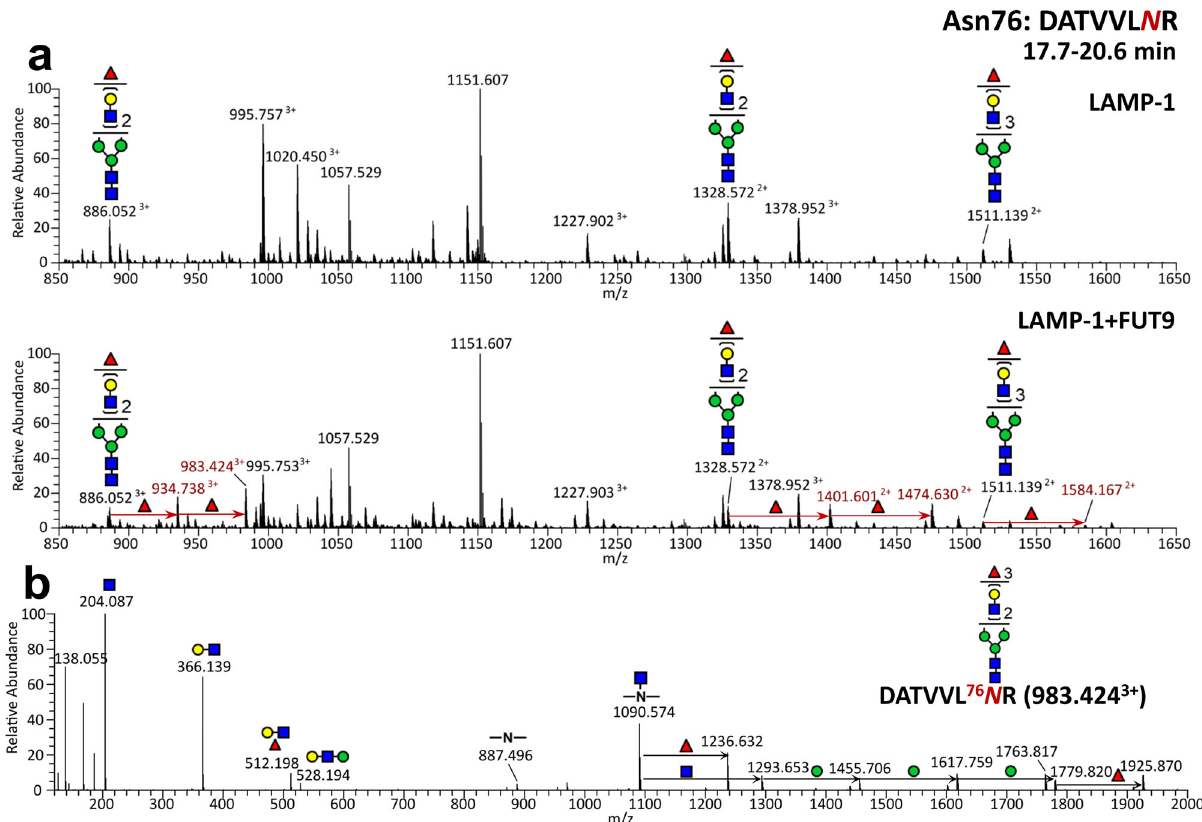
Fig. 2 Representative MS pro fi ling of site-speci fi c glycosylation of LAMP-1. a The representative LC-MS spectrum of the glycopeptide containing the Asn76 N-glycosylation site from LAMP-1 produced in wild-type or FUT9-expressing CHO-K1 cells. The peptides containing the Asn76 N-glycosylation site eluted in a time range of 17.7 – 20.6 min. b The representative LC-MS/MS spectrum of the Asn76-containing glycopeptide of LAMP-1 co-expressed with FUT9. The LAMP-1 glycoproteins subjected to the LC-MS measurement were prepared from the gel pieces according to the procedure described in the Methods section. The glycan composition and probable structures were inferred from the few critical fragment ions afforded and the expected range of documented N-glycan structures in the literature. Man, Gal, Fuc, and GlcNAc are represented by symbols according to the Symbol Nomenclature for Glycans (SNFG)